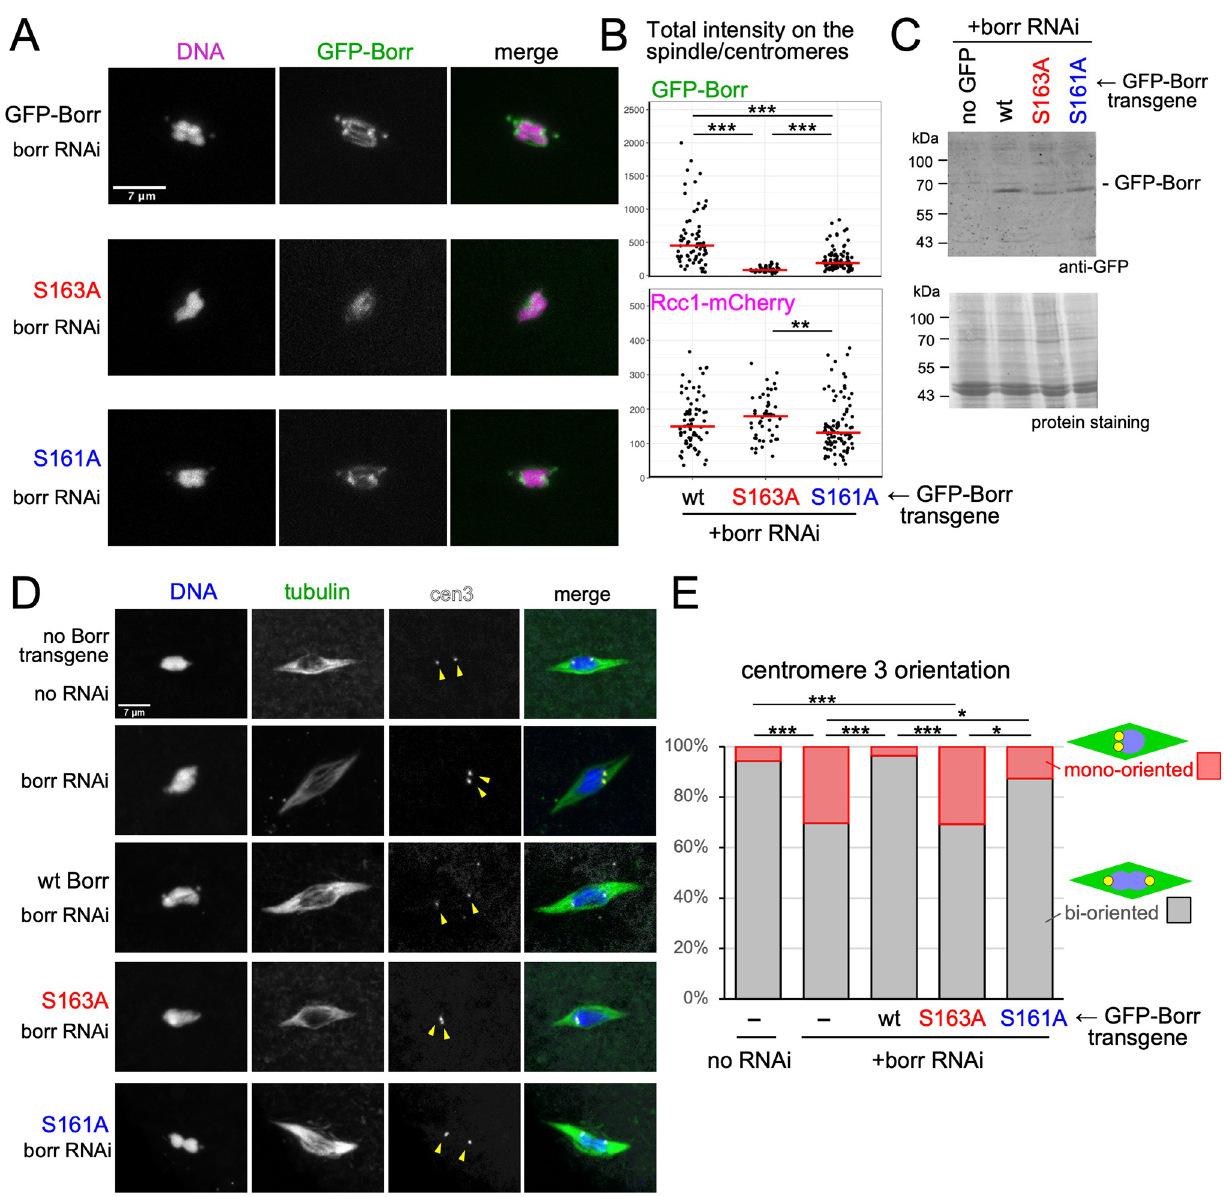
Fig 4. Non-phosphorylatable mutations compromises the localisation of Borealin and bi-orientation of centromeres in oocytes. (A) Non- phosphorylatable mutations (S163A, S161A) reduce the Borealin localisation to the spindle and centromeres. Fluorescence was observed in live oocytes expressing the GFP-tagged RNAi-resistant wild-type or non-phosphorylatable mutants together with a short hairpin RNA (shRNA) against the endogenous gene and a red chromosomal marker, Rcc1-mCherry. The images were presented using the same condition of capture and contrast adjustment for comparison. (B) The total signals of GFP-Borealin and Rcc1-mCherry on the spindle and centromeres above the background was quantified. Red lines indicate the median signal intensities. ��� and �� indicate p < 0.001 and p < 0.01, respectively (Wilcoxon rank sum test). (C) Western blot of ovaries expressing GFP, wild-type ovaries without expression of GFP, and ovaries expressing wild-type or mutant GFP-Borr (S163A or S161A) in the background of borr RNAi, probed with an anti-GFP antibody and protein staining. (D) Non-phosphorylatable mutations (S163A, S161A) compromises the Borealin function in the bi-orientation of centromeres. α -tubulin and peri-centromere 3 (dodecasatellite; arrowheads) were visualised by Immunostaining combined with in situ hybridisation in borr RNAi oocytes with or without expression of the wild-type or non-phosphorylatable Borealin mutants. (E) Frequencies of bi-orientation of homologous centromeres of chromosome 3. Two separate dodecasatelite signals near both ends of the chromosome mass are considered as bi-oriented centromeres, and one or closely located two signals on the one side of the chromosome mass are considered as mono-oriented centromeres. ��� and � indicate p < 0.001 and p < 0.05, respectively (Fisher exact